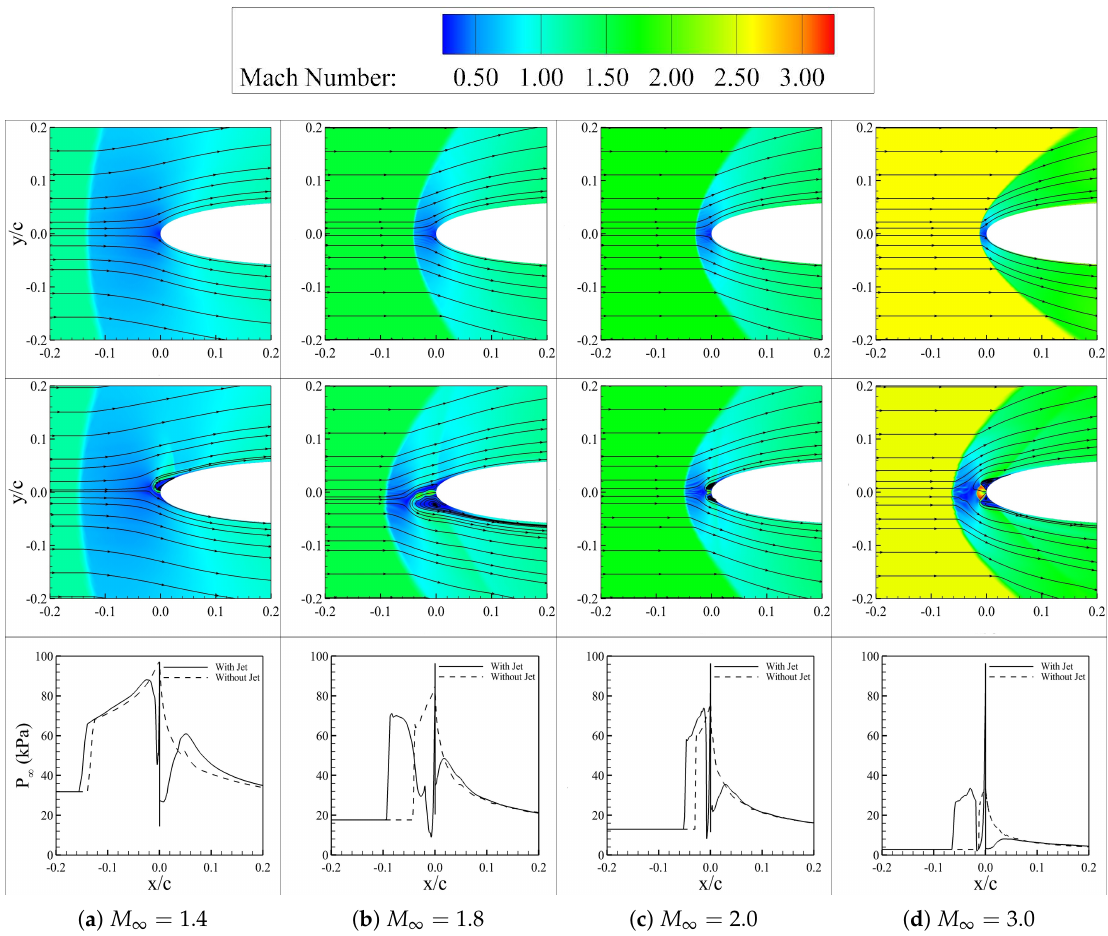
Figure 8. Comparison of stream lines for Mach contours with constant PR = 1:8, M j = 1 and also includes the changes in pressure with increasing Mach